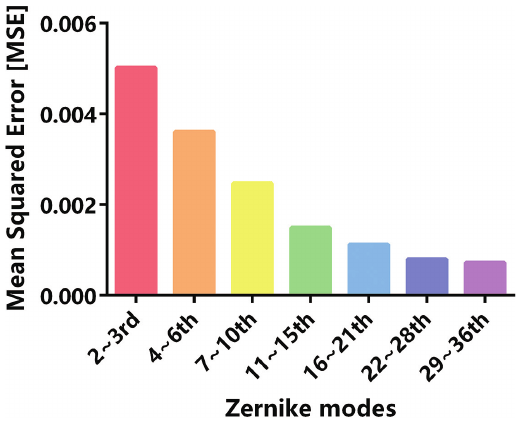
Fig. 4. The MSE of predicted Zernike mode coe±cients.